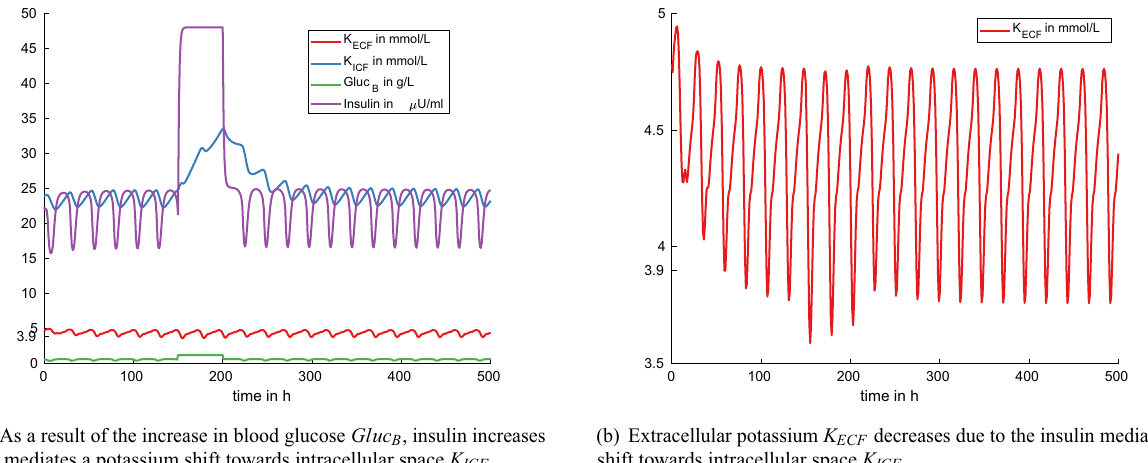
Figure 7. Experiment 6: hyperglycaemic clamp with the model component Gluc B set manually to 1.2 at time t = 150 h for 50 h (default model setting with p 55 = 0.9 , p 54 = 1.2